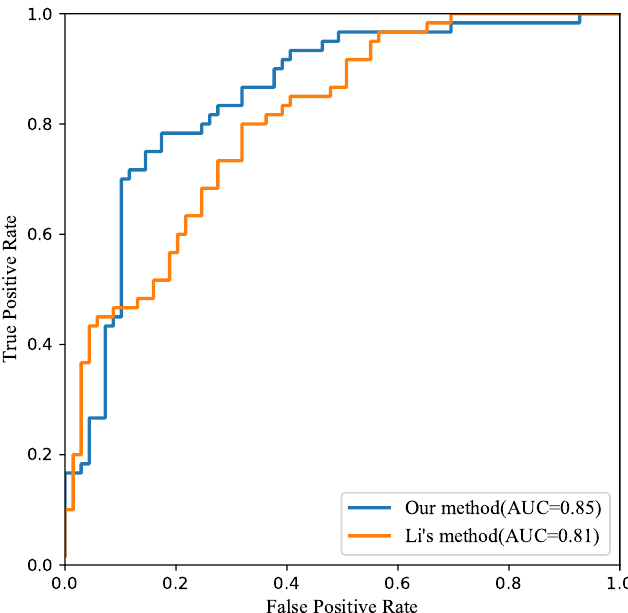
Figure 4. ROC curves for Li’s method and our method. Li’s method has an AUC of 0.81 and our method has an AUC of